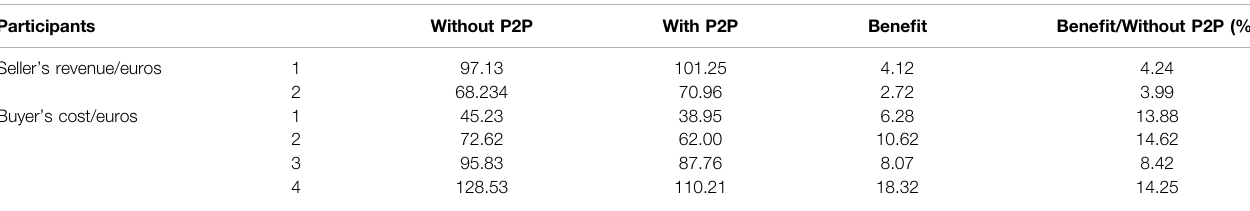
TABLE 7 | Comparison of participant ’ s cost and revenue/euros.